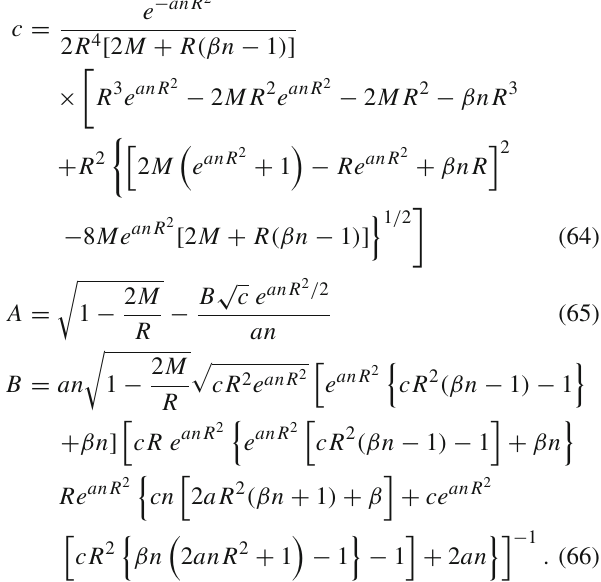
with j = e − (λ + ν)/ 2 at boundary value j ( R ) = 1. The moment of inertia solutions I up to the maximum mass M max have been provided by Bejger and Haensel [94]